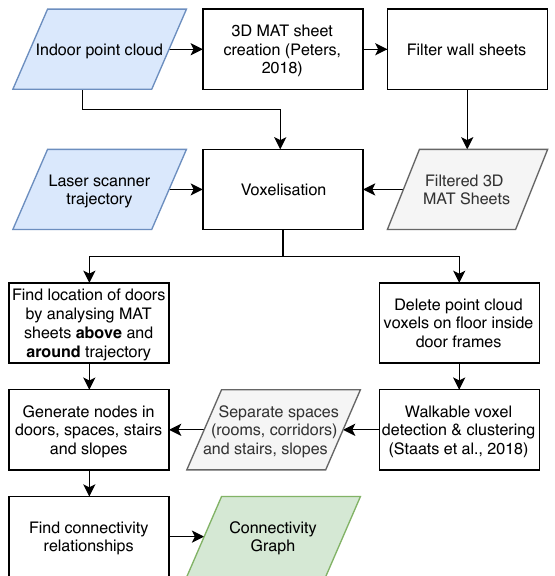
Table 1. Theoretical parameters for filtering MAT sheets